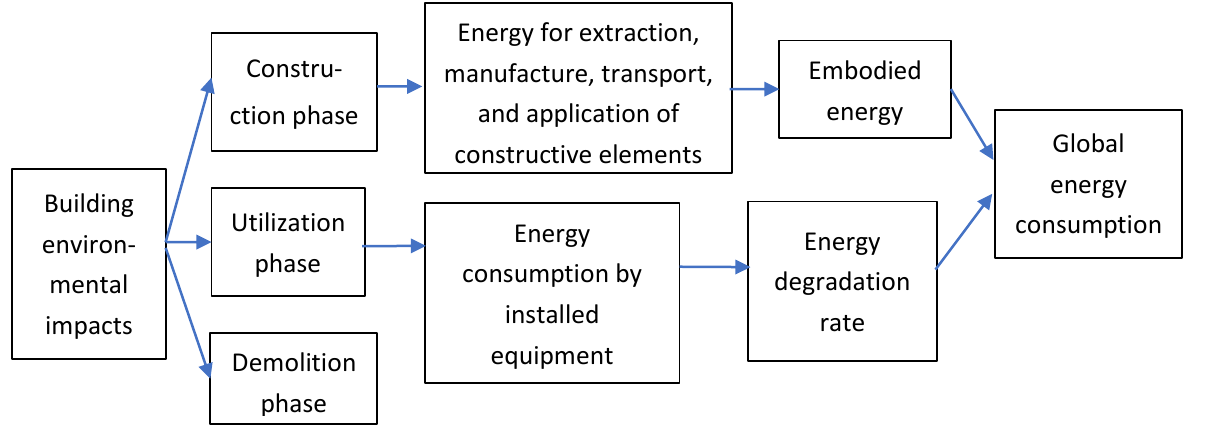
Figure 3. Block diagram of the building’s global energy consumption calculation.